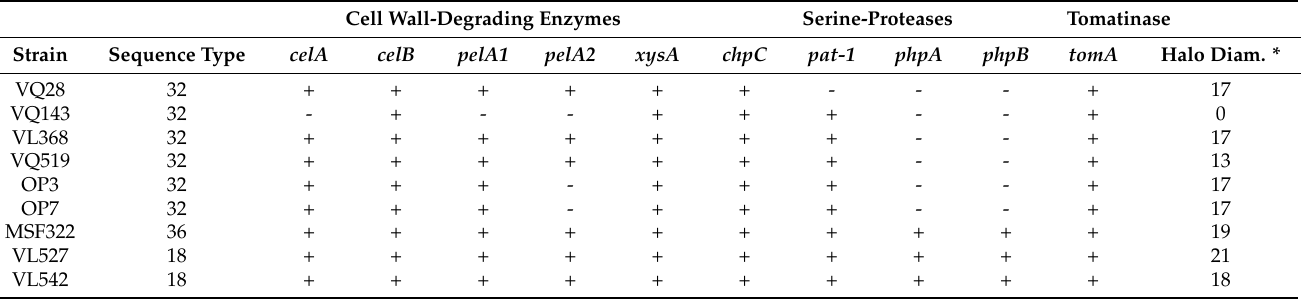
Figure 3. Cellulase activity of the nine Clavibacter michiganensis subsp. michiganensis strains. Bacterial isolates were grown and their concentration adjusted. After 4 days of incubation, TCYA plates were stained with Congo Red. The size of halos was measured. ( a ) Plate containing the strains (from above in clockwise order): VQ28, VQ143, MSF322, VL368, and VQ519. ( b ) Plate containing the strains (from above in clockwise order): VL527, VL542, OP3, OP7, and negative control. Table 3. Detection of virulence genes by PCR and cellulase activity of the nine Chilean Clavibacter michiganensis subsp. michiganensis